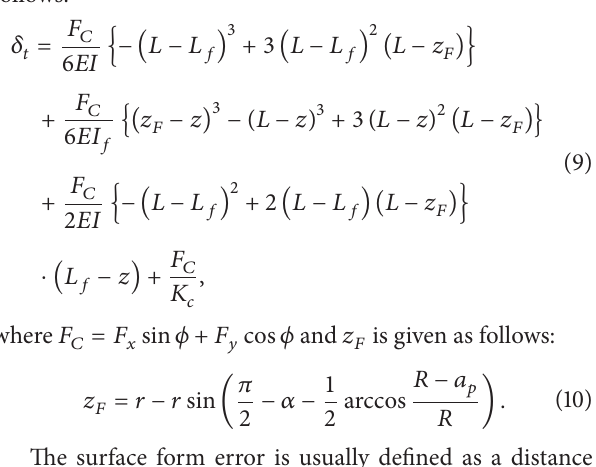
Figure 3: Bending model of ball-end milling.